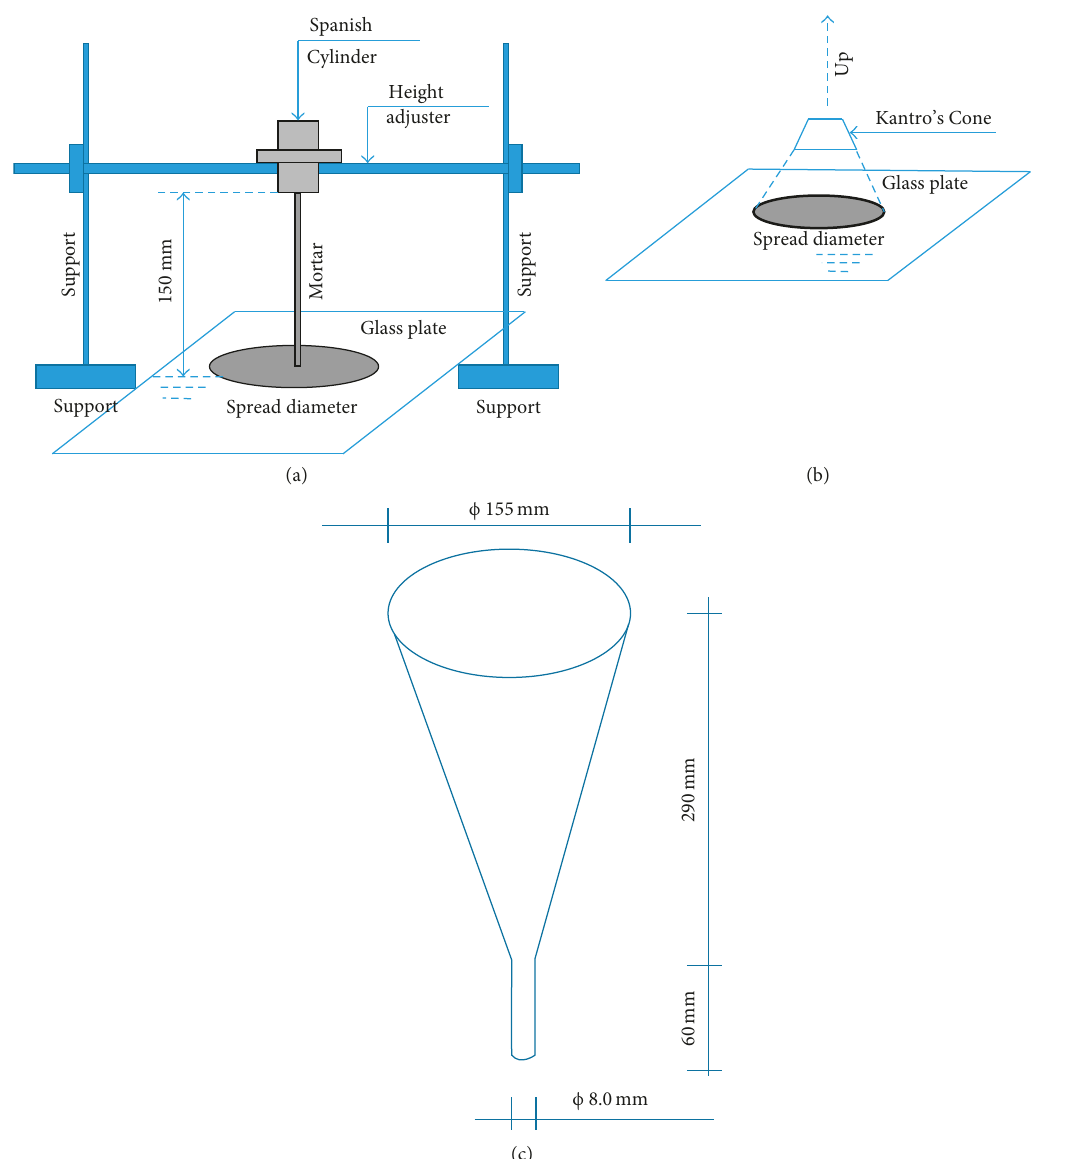
Figure 3: Equipment used to measure fluidity and the outflow rate. (a) Spanish Cylinder; (b) Kantro’s Cone; (c) Marsh